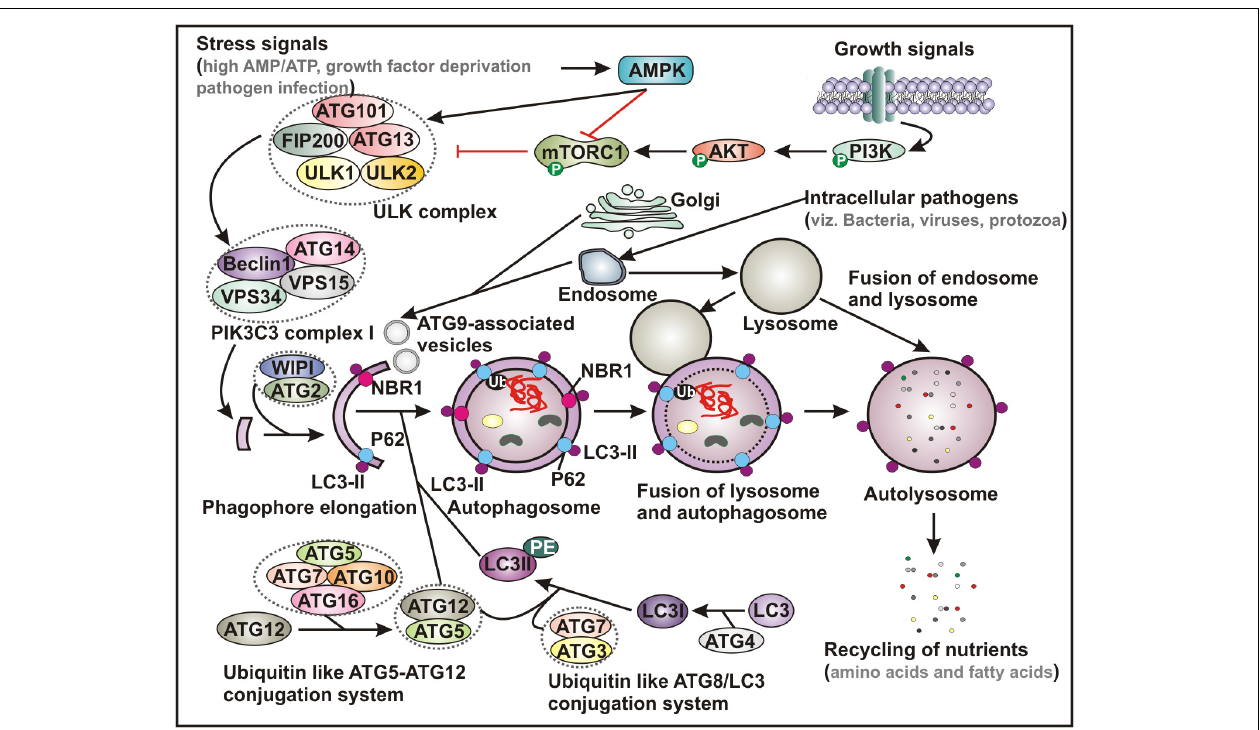
FIGURE 1 | Schematic representation of basic autophagy pathway. Upon deprivation of growth factors, increase in AMP level and pathogen infection lead to AMPK activation and subsequent inhibition of mTORC1 function. In contrast, in the presence of growth signals PI3K-AKT signaling pathway activates mTOR. Inhibition of mTORC1 results in activation of ULK complex, which phosphorylates Beclin-1, leading to VPS34 activation and initiation of phagophore formation. ULK functions in a complex with ULK1, ULK2, FIP200, ATG13 and ATG101, while VPS34 function within the PIK3C3 complex containing its regulatory subunit, VPS15, ATG14 and Beclin-1, which further recruits to WIPI and ATG2 for phagophore elongation. Several ATG proteins engage two evolutionarily conserved ubiquitin-like conjugation systems - ATG12-ATG5 and phosphatidylethanolamine (PE)-conjugated LC3 (LC3-II) targeted to the pre-autophagosomal membrane. In the ATG12-ATG5 conjugation system, the complex further interacts with ATG16, where ATG7 functions as an E1-like enzyme and ATG10 factions as an E2-like enzyme. In the other system, LC3 is first cleaved by a cysteine protease ATG4 to generate LC3-I, which is further conjugated with PE to form membrane bound LC3-II facilitated by ATG7 and ATG3. The cytoplasmic damaged cargo is then ubiquitinated, captured by adaptor molecules - p62 or NBR1 and subsequently delivered to the phagophore membrane. Matured autophagosome then fuses with endolysosomal vesicles forming an autolysosome, where the cargo is degraded and provide nutrients. AMPK, AMP activated protein kinase; mTORC1, mammalian target of rapamycin complex 1; PI3K, phosphatidylinositol 3-kinase; PIK3C3, Phosphatidylinositol 3-Kinase Catalytic Subunit Type 3; LC3, microtubule-associated protein 1 light chain 3; Ub, ubiquitin; NBR1, neighbor of BRCA1 gene